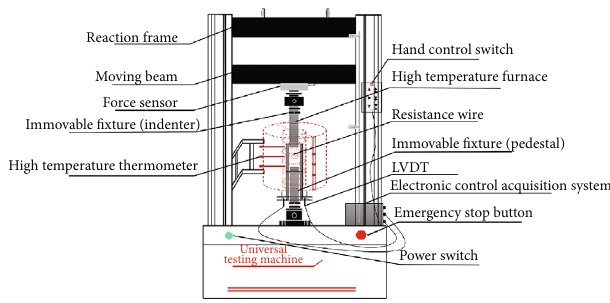
Figure 1: Microcomputer-controlled electronic universal testing